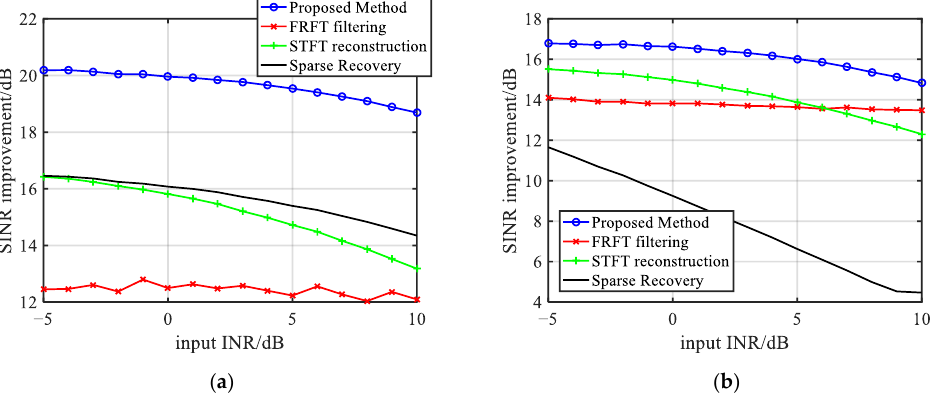
Figure 13. Comparison of SINR improvement of the proposed method with FRFT filtering, STFT reconstruction and Sparse Recovery. ( a ) ISRJ; ( b ) SMSP jamming.